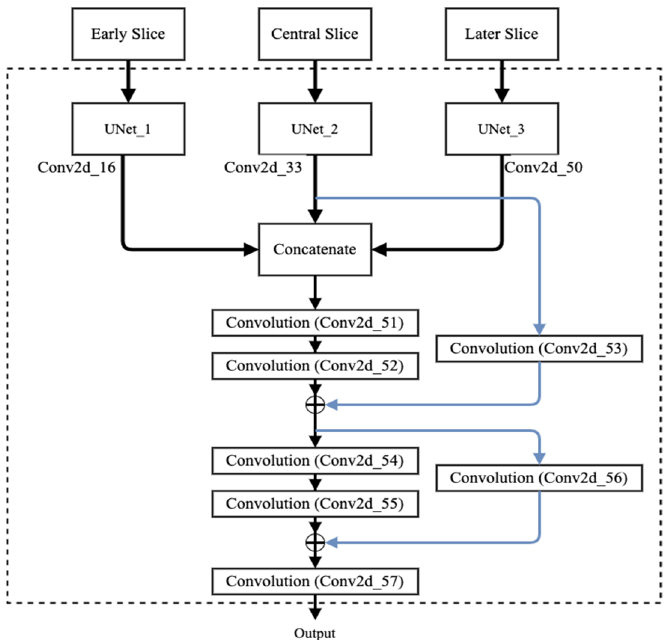
Figure 6. Illustration of the proposed network for the fusion of the filters from parallel Unets. The corresponding layer names that are input for the concatenation are from the Table 2. The output features of Conv2d_16, Conv2d_33, and Conv2d_50 are the input for the concatenation before the residual network as shown in the figure. Table 2. Architecture of the proposed residual network for merging the parallel Unets.